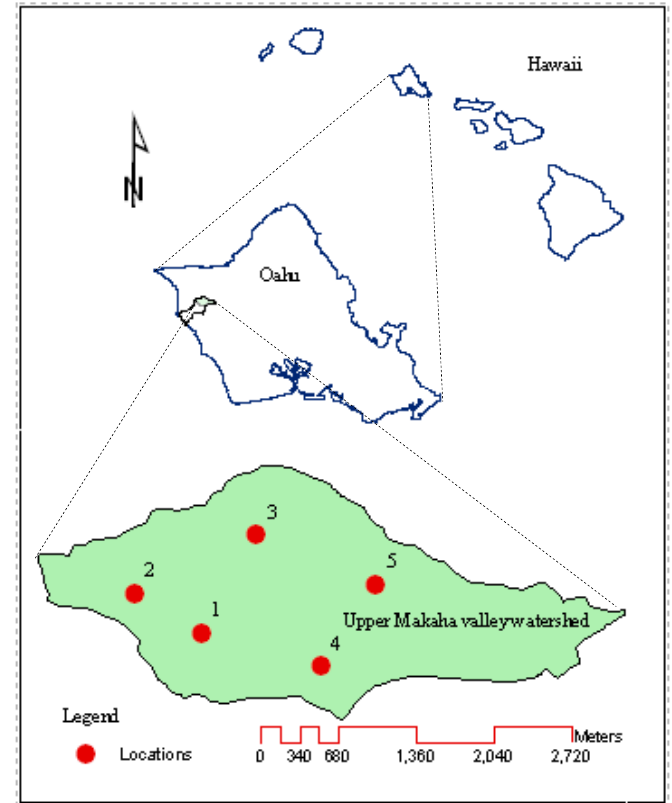
Figure 1. The map of the Upper Mākaha Valley sub-watershed showing the five laboratory calibration study locations where the sensors are installed and from which soil samples were collected and used for this